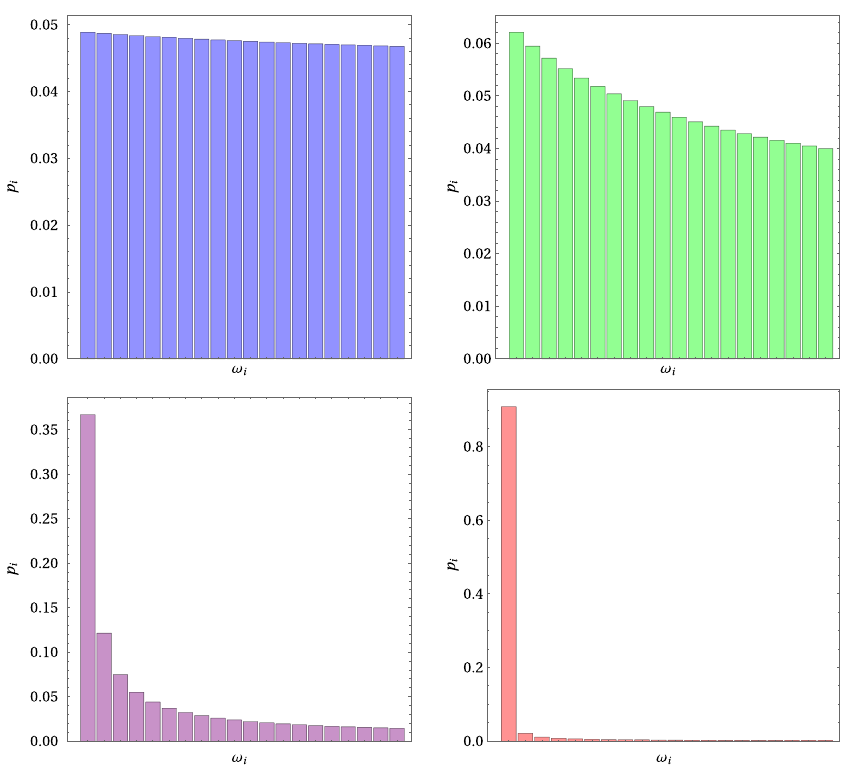
FIG. 1. Classical Fröhlich-like condensation. Normalized fractions of energy p system I for a fixed number of modes: N ¼ 20 . The histograms display increasing deviations from energy equipartition among the sys normal modes as the energy input rate S increases. The spectra correspond to S ¼ 0 . 1 (blue), S ¼ 1 (green), S ¼ 10 (purple), and S ¼ 100 (pink). Equipartition corresponds to equal heights of the bars. Note the great difference among the energy fractions in the lowest normal mode and in the higher frequency